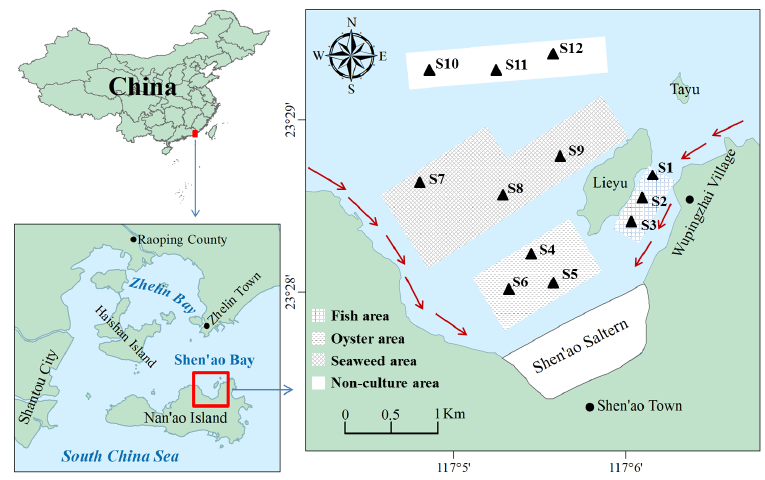
Fig. 1. Sampling stations ( M ) from March to May in Shen’ao Bay, China: S1−S3 in the fish culture area, S4−S6 in the oyster culture area, S7−S9 in the seaweed culture area, and S10−S12 in the non-culture area. The red arrows represent the direction of the